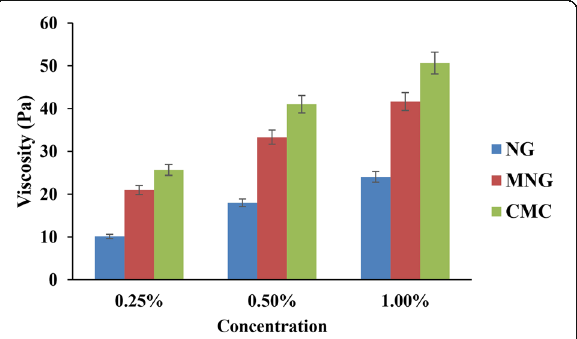
Fig. 4 Comparative suspension viscosity at different suspending agent concentrations in paracetamol suspension formulations